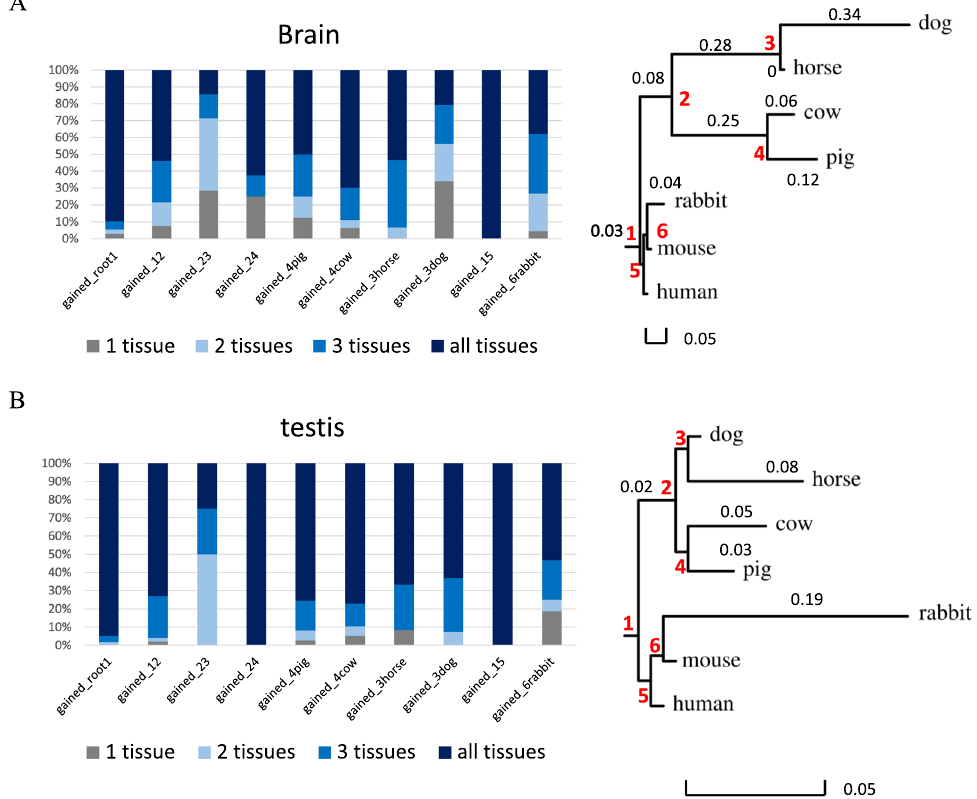
Figure 5. Expression patterns across the phylogeny for all miRNA orthogroups expressed in brain ( A ) and testis ( B ). Colour labelling indicate the number of miRNA families expressed in a specific tissue, divided in the following categories: tissue specific; expressed in the tissue + n additional ones (n = 3 indicated as “all tissues”). Branch lengths in the phylogenetic trees are proportional to the fraction of tissue specific